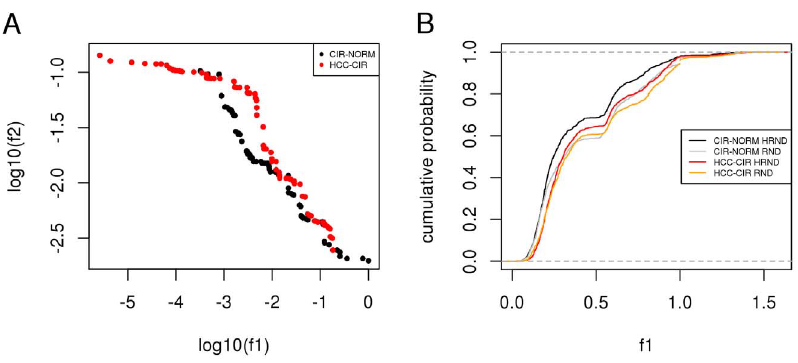
Figure 5. Differential expression in network proximity to HCV proteins. A ) Gene expression variation (log 10 ( f 1 )) and network proximity (log 10 ( f 2 )) of optimal networks (Pareto fronts) identified for CIR-NORM and HCC-CIR comparisons. B ) Estimated cumulative probability functions of gene expression variation ( f 1 ) of 1,000 random networks (RND) and 1,000 HCVassociated random networks (HRND) in CIR-NORM and HCC- CIR comparisons. A–B ) the lower the value of f i the higher the enrichment in the corresponding quantity.